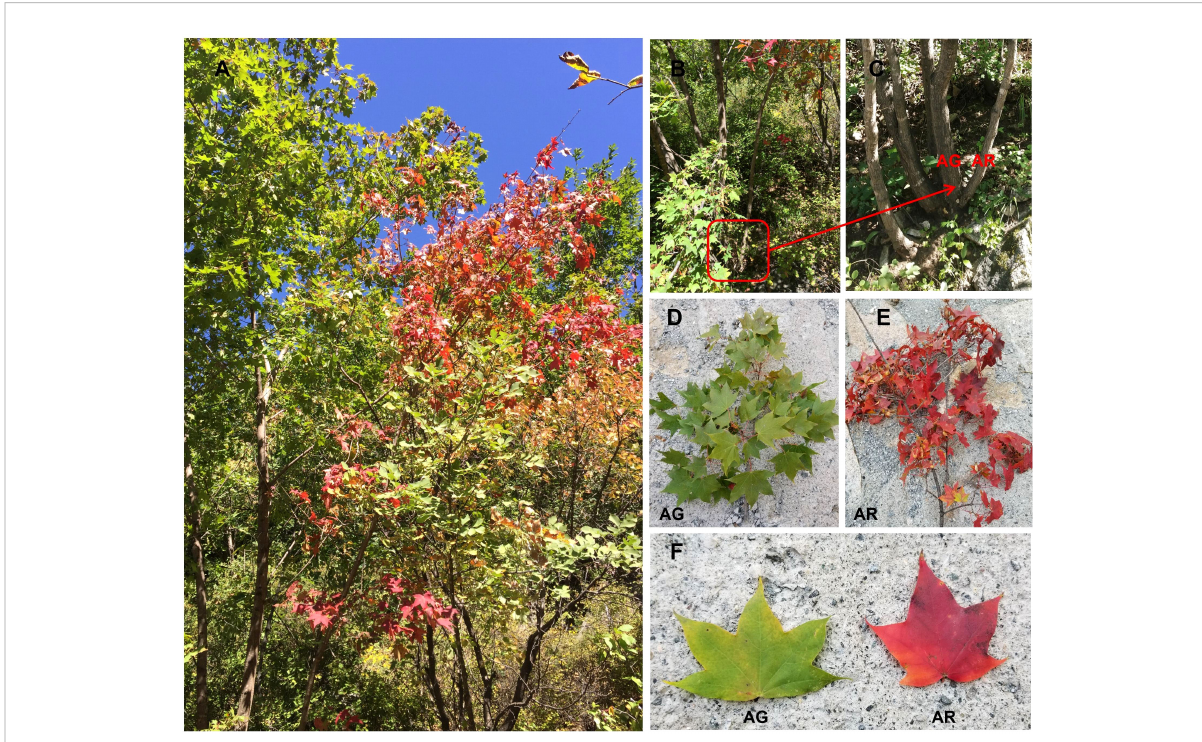
FIGURE 1 Acer p. subsp . mono with bud mutation branches found in the wild. (A) Acer p. subsp . mono with bud mutation branches in autumn. (B, C) are wild-type branches (AG) and bud mutation branches (AR) of A. p. subsp. mono in autumn. (D – F) Green leaves of wild-type branches (AG) and red leaves of bud mutation branches (AR) in